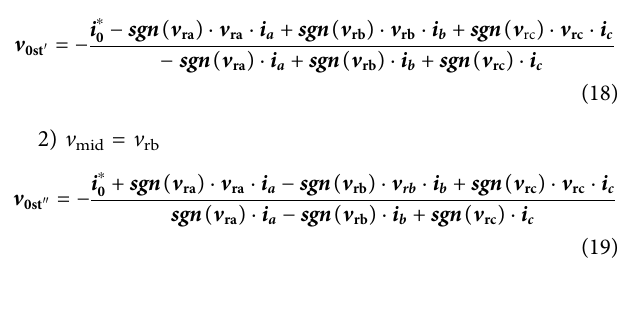
Frontiers in Energy Research |